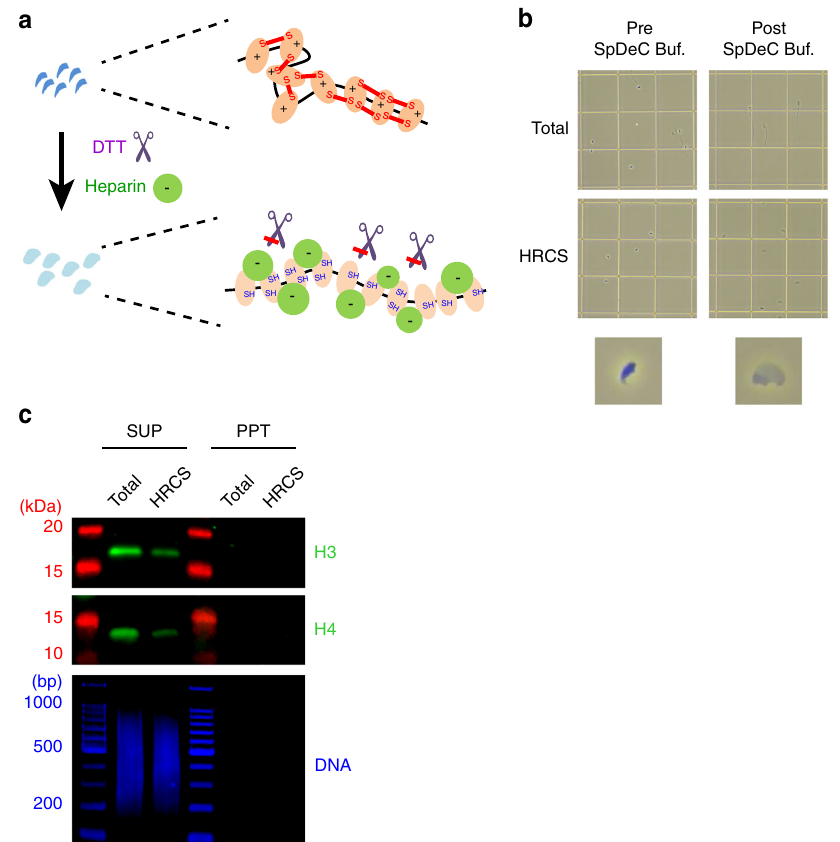
Fig. 2 Solubilization of histones and DNA from cross-linked sperm cells after decondensation treatment a Schematic diagram for expected molecular reaction during sperm decondensation treatment. (Top) Sperm DNA is highly compacted by polymerized protamine via disul fi de bonds (red lines), and protamine tightly binds to DNA through ionic interactions. (Bottom) After treatment with sperm decondensation buffer, the reducing capacity of dithiothreitol (DTT) cleaves the disul fi de bonds, and the positive charge in protamine molecules is neutralized by the negative charge of heparin, leading to decondensation of the DNA – protamine complex. b The morphology of total sperm and HRCS fraction before and after treatment with sperm decondensation buffer. Sperm morphology was observed under a MAKLER-style cell counter (0.1 × 0.1 mm). c Total sperm and HRCS fractions were cross- linked, incubated with sperm decondensation buffer, sonicated, and centrifuged. Immunoblot analysis of H3 and H4 using the supernatant and pellet fraction from 4 × 10 4 cells was